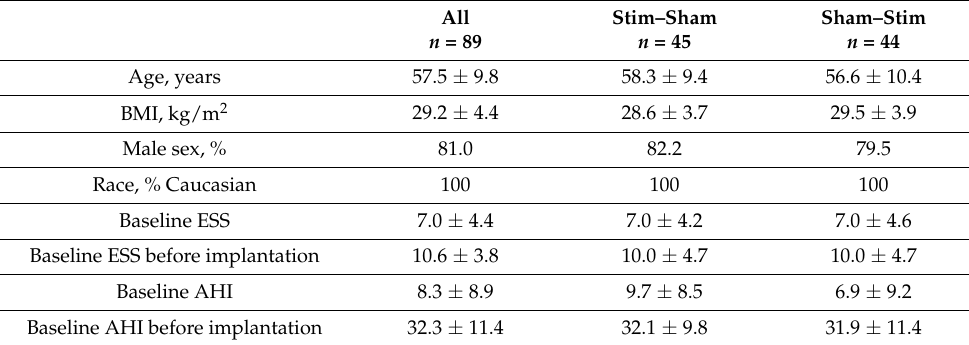
Table 1. Baseline Characteristics by Randomization